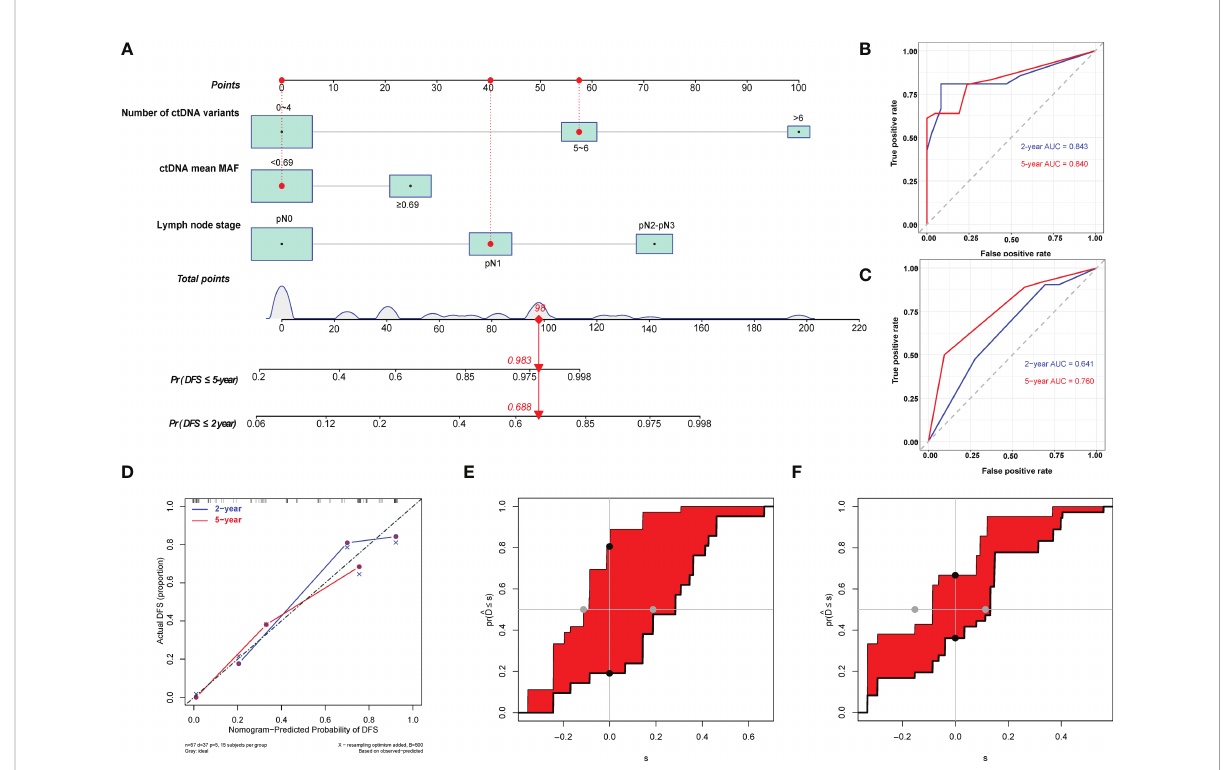
FIGURE 4 Development and evaluation of nomogram for disease-free survival prediction in patients with esophageal squamous cell carcinoma. (A) Nomogram based on preoperative circulating tumor DNA features for disease-free survival (DFS) in patients with resectable esophageal squamous cell carcinoma. The prediction result of patient no. 28 is listed as an example. Each subgroup within the variables was assigned a score. To determine the score of each independent prognostic factor, a vertical line was drawn from each factor axis to the “ Points ” scale; the position of the red dot on the “ Points ” axis indicates the score of this factor (pN1 LNS, score = 40; mean ctDNA MAF = 0.31%, <0.69%, score = 0; and six variants of ctDNA, score = 58). The predicted probability of DFS can be found vertically below the location of the Total Points. The total scores for all three predictors were summed to get the “ Total points ” value (40 + 0+58 = 98, which is indicated as a red diamond on the “ Total points ” scale). The red arrow on the “ Pr ” axis indicates the recurrence probability in the corresponding years (the recurrence probability within two years was 0.688, and the recurrence probability within fi ve years was 0.983). (B) Receiving operating characteristic (ROC) curves of the nomogram for predicting 2-year and 5-year DFS. (C) ROC curves of the TNM staging system for predicting 2-year and 5-year DFS. (D) Calibration plot of the nomogram for predicting DFS. (E) Integrated discrimination improvement (IDI) between the developed nomogram and the TNM staging system for predicting 2- year DFS. (F) IDI between the developed nomogram and the TNM staging system for predicting 5-year